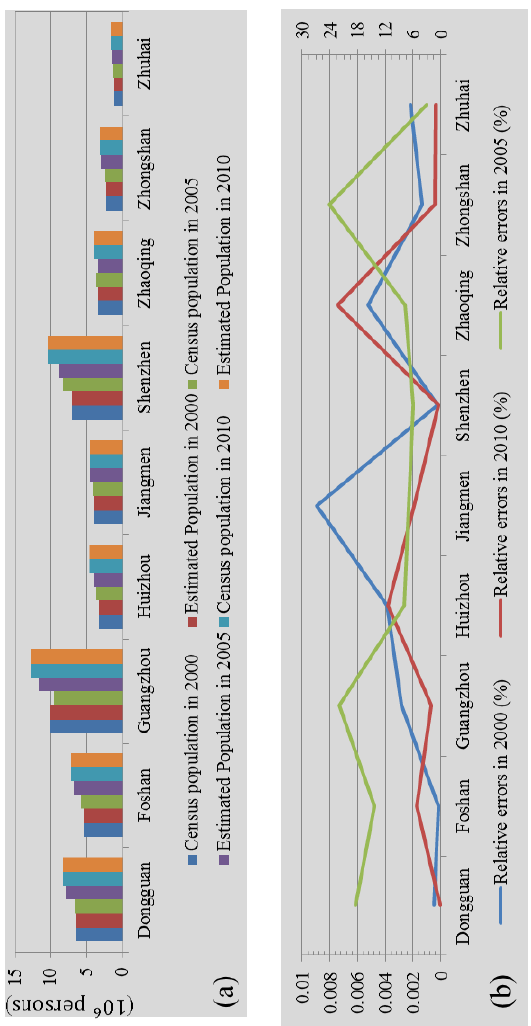
Figure 2. The comparison between census population and estimated population from 2000 to 2010, including (a) population in each city and (b) relative errors in each